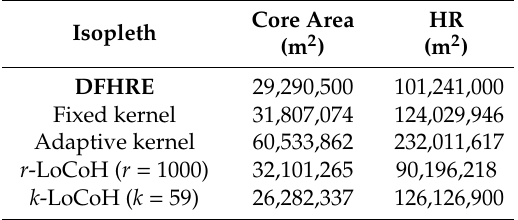
Figure 17. HR of the KDE methods for Dataset 3. Table 3. Sizes of the core areas and HRs estimated by the DFHRE, KDE and LoCoH methods for Dataset 3.